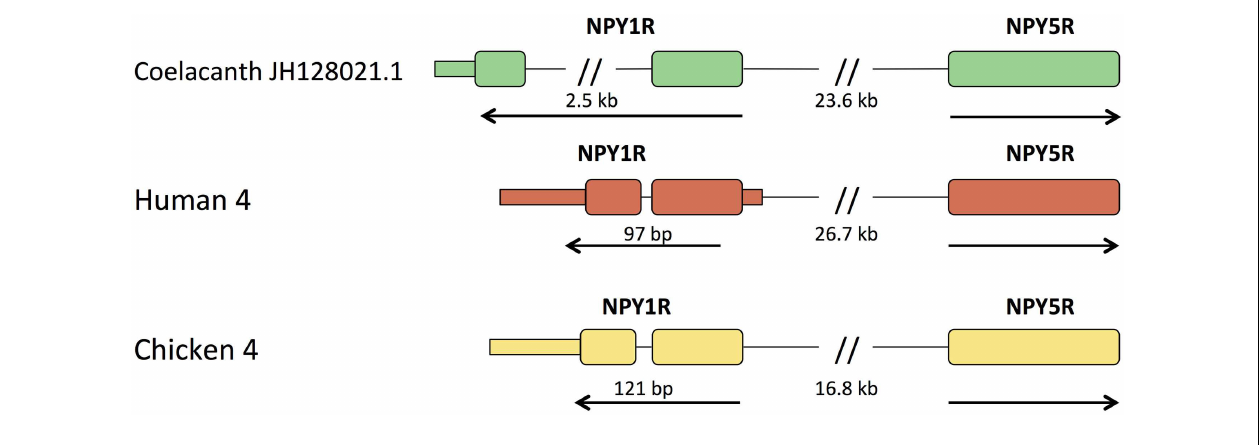
coding region ofY1 is shown. In all three species, the genes have a “head-to-head” orientation and may share regulatory upstream elements. The distance between the coding regions of the two genes are shown, but it has not yet been fully explored where promoters and any separate 5 (cid:48) -untranslated exons may be located.